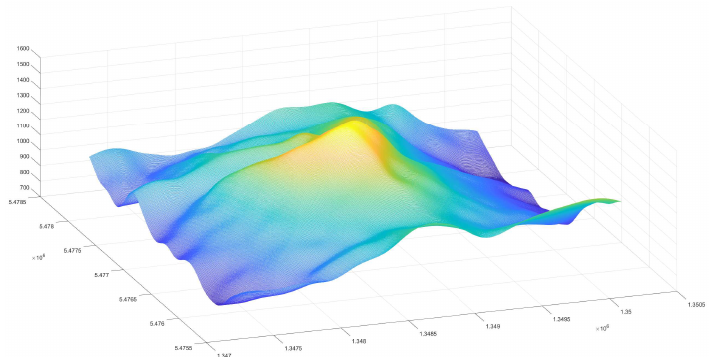
Figure 16. The surface fitting with real data.